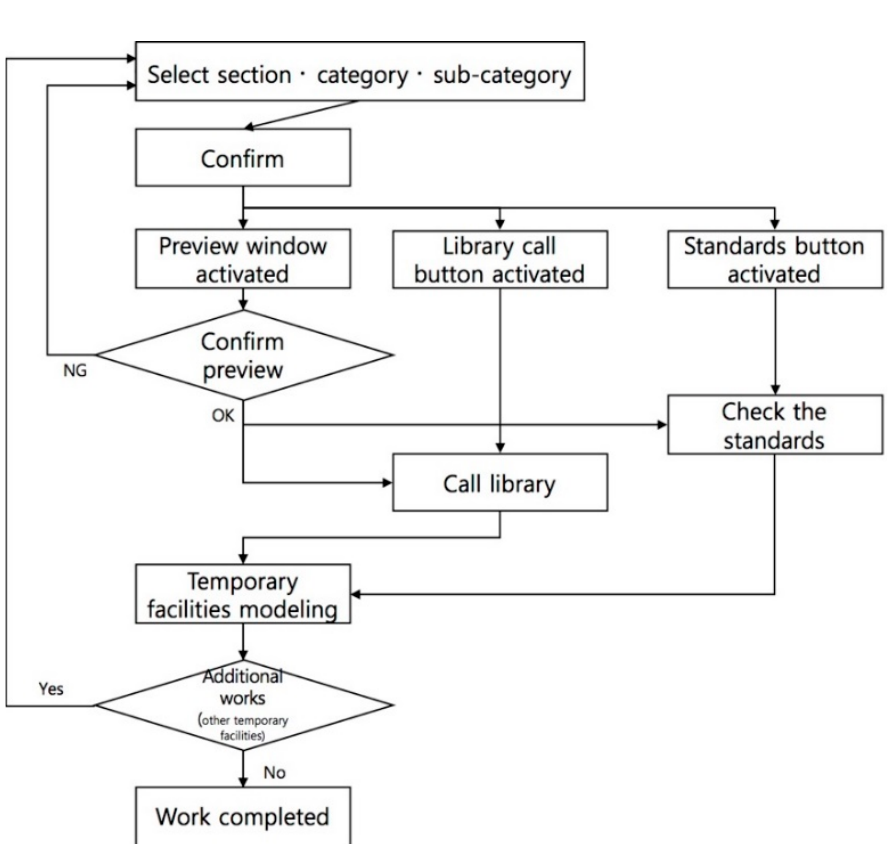
Figure 5. Process flowchart—BIM modeling module.